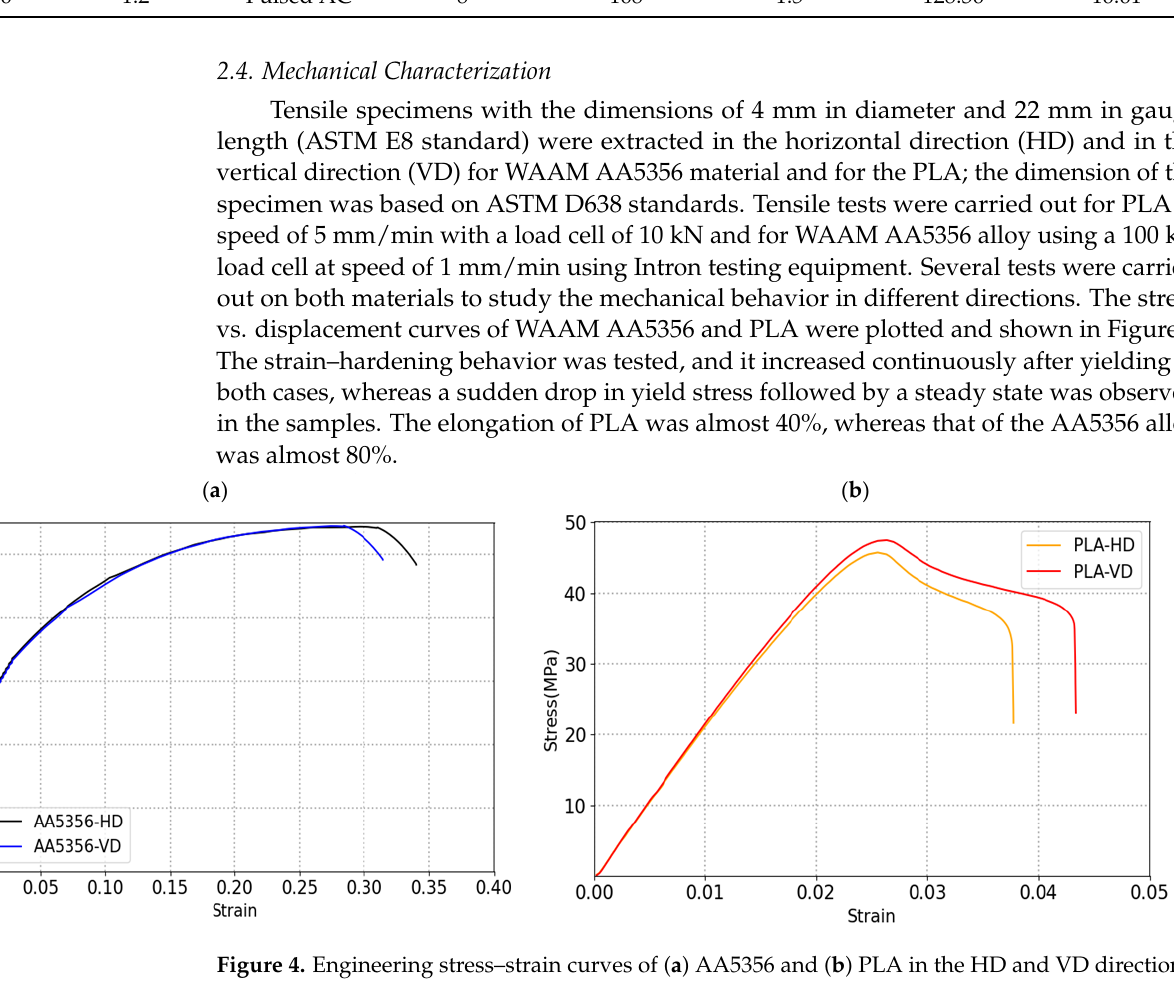
Table 3. Statistical analysis on the tensile results of AA5356 alloy and PLA.